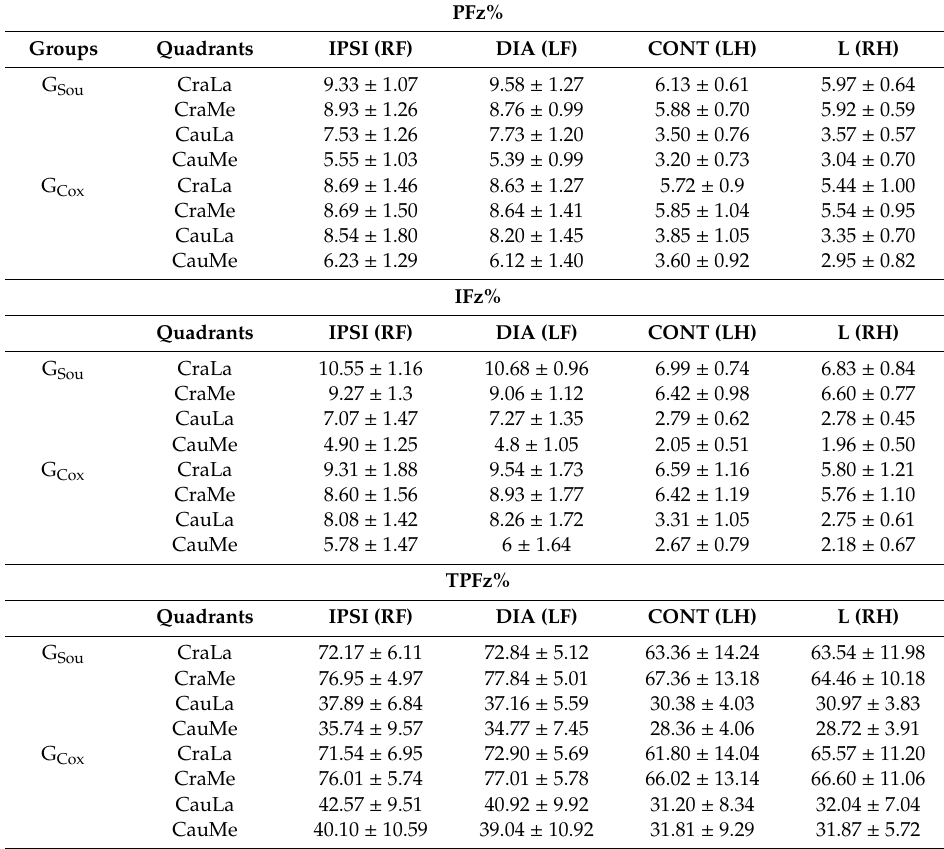
Table 5. The mean values ± standard deviations of PFz%, IFz%, and TPFz% in the CraLa, CraMe, CauLa, and CauMe quadrants of the IPSI (RF), DIA (LF), CONT (LH), L (RH) limbs from the G Sou and G Cox